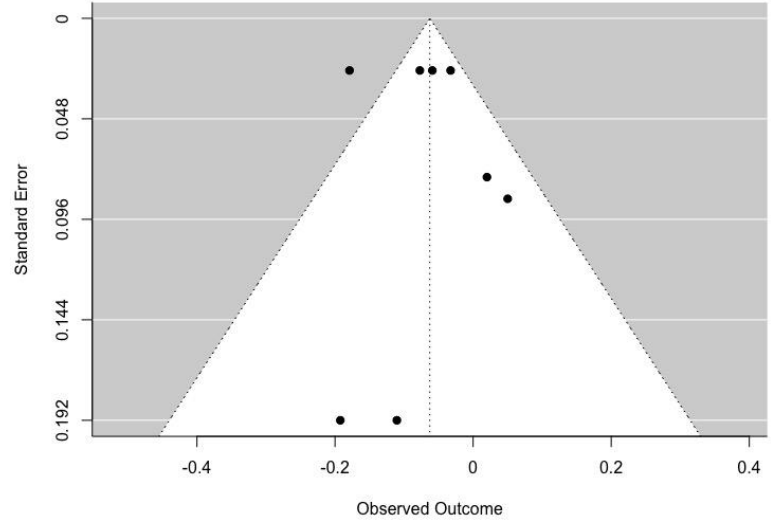
Figure 4. Funnel plot for the associations between discouragement parental influence and PA level.